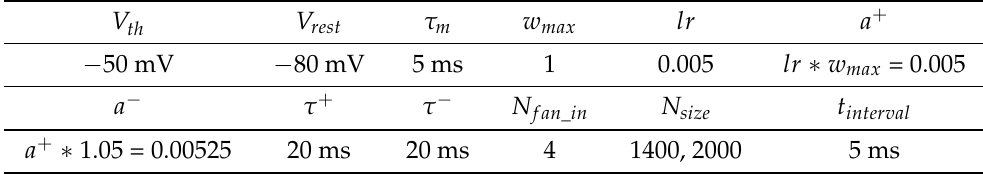
Table 2. The parameter values used in